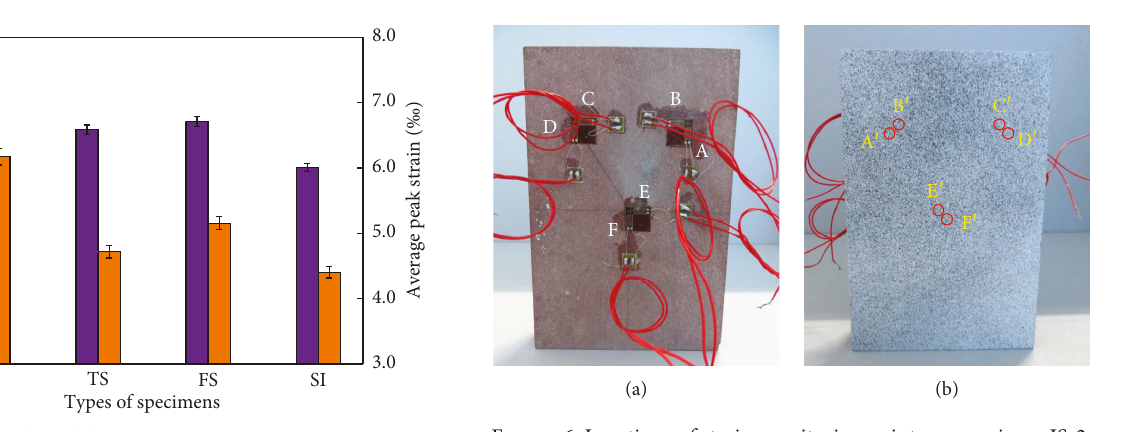
Figure 6: Locations of strain monitoring points on specimen IS-2: (a) back surface; (b) front speckle surface.